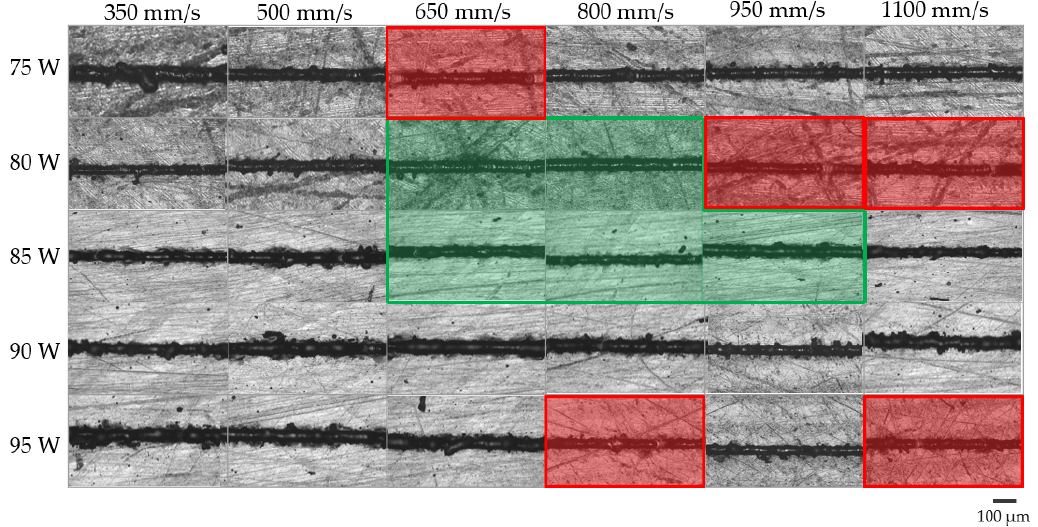
Figure 10. Process window with optical micrographs of on top AlSi10Mg SSTs with a layer thickness of 25 μ m.